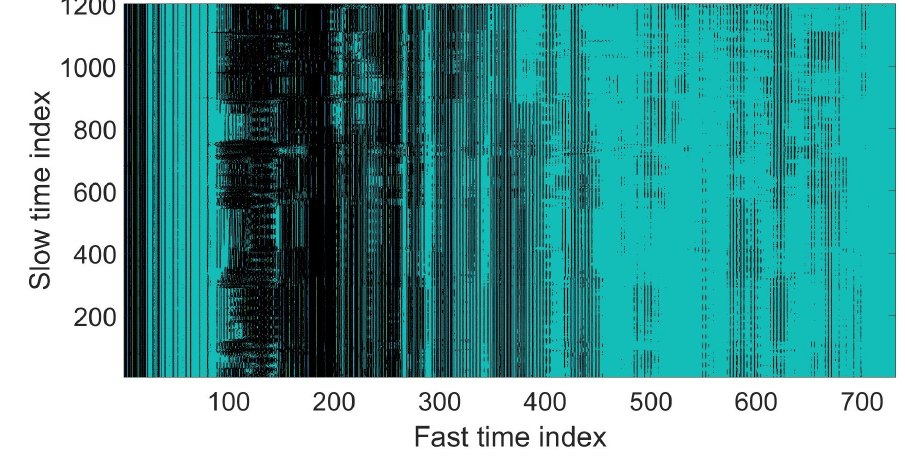
Figure 7. Fast time signal before clutter removal.